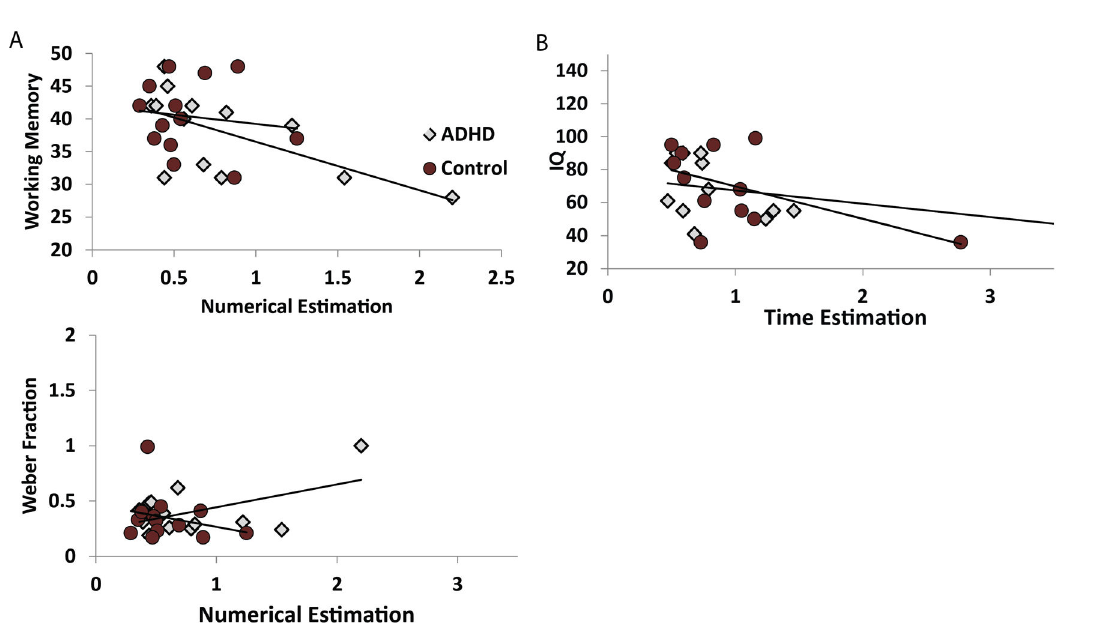
Figure 3. Correlations between estimations and domain specific and domain general factors. Note. Hierarchical regression was performed on cognitive estimation. Group was defined as a dummy variable. The results indicated that the approximate number sense, a preverbal domain specific ability, predicted numerical estimation. Please note that this tendency was stronger among the ADHD group compared to the control group (top panel A). Moreover, working memory forward was also related to numerical estimation (bottom panel A). However, cognitive estimation of time was predicted by IQ. Please note that this tendency was stronger among the ADHD group compared to the control